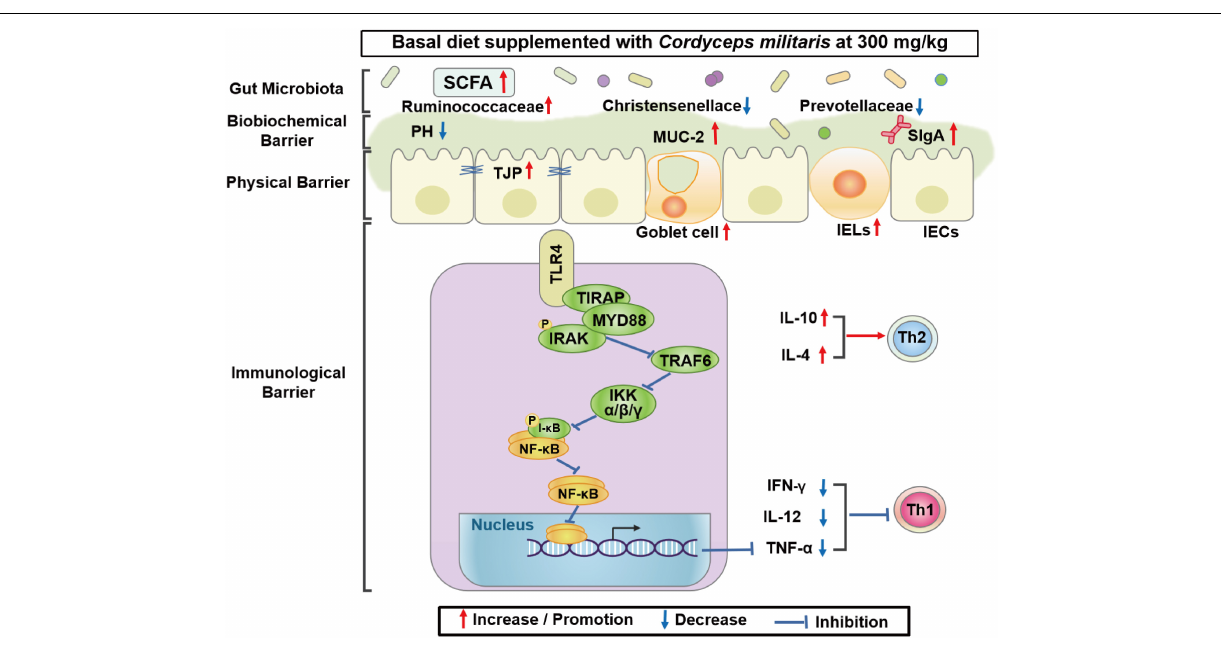
FIGURE 7 | Proposed model of the effects of CM on intestinal barrier function and gut microbiota of pigs. Diagram showing the effects of CM on the intestinal physical barrier, biochemical barrier, immunological barrier, and gut microbiota. Mechanistically, CM may inhibit inflammation via the TLR4/MyD88/NF- κ B signaling